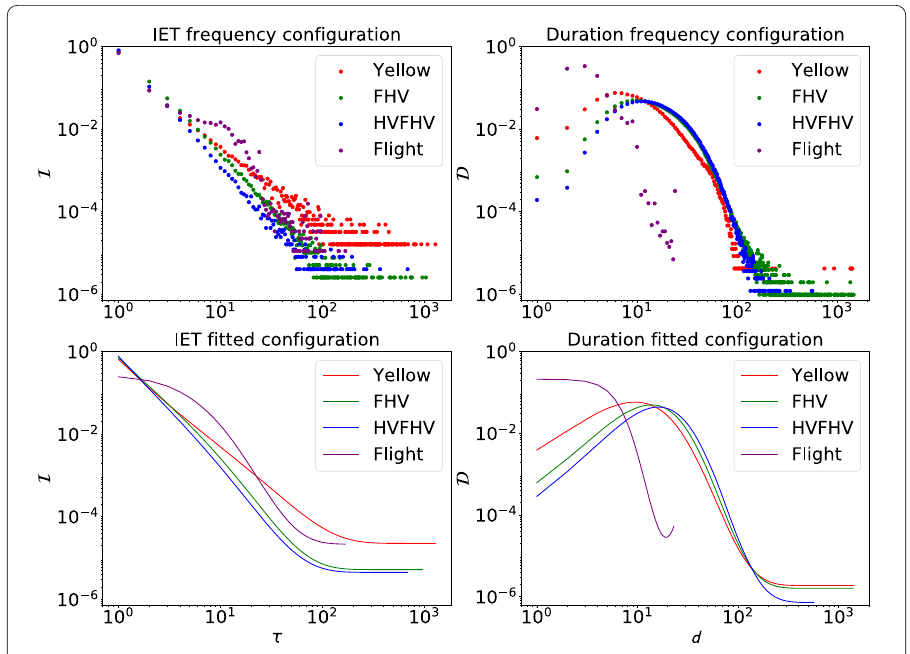
Figure 4 The IET and duration values used in frequency and fitted configuration. In frequency configuration (upper left and right), statistical estimations of real measures are directly used as input schema. In fitted configuration, IET (lower left), duration (lower right) distributions are used directly as estimated from real networks, and the fitted result are used for I and D